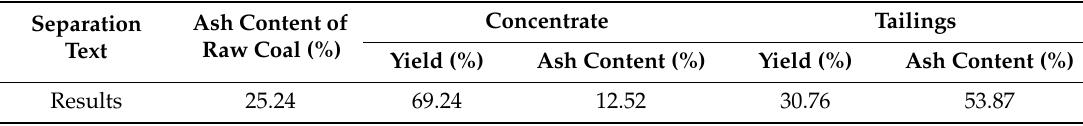
Figure 11. Response surface of K of − 6 + 1 mm fine coal for various factors. ( a ) The response surface and its contour of K for different values of the amplitudes and D ; ( b ) the response surface and its contour of K for different values of the frequencies and θ ; ( c ) the response surface and its contour of K under different H and D. Table 9. Separation results of fine coal in a compound dry